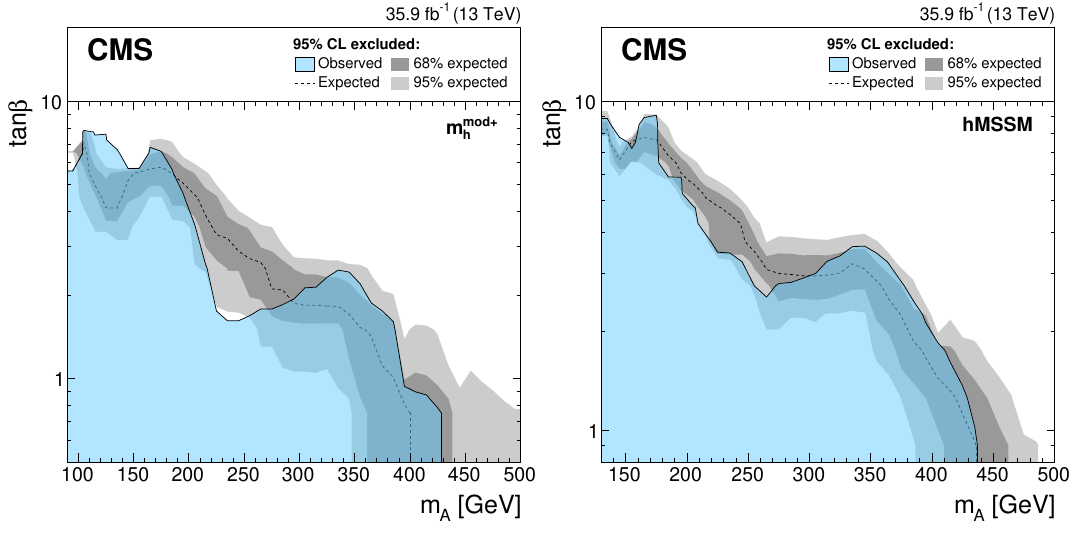
Figure 8 . Expected and observed 95% CL upper limits on tan (cid:12) as a function of m (left) and hMSSM (right) scenarios. The expected limit is shown as a dashed black line while the dark and light gray bands indicate the 68 and 95% CL uncertainties, respectively. The observed exclusion contour is indicated by the blue